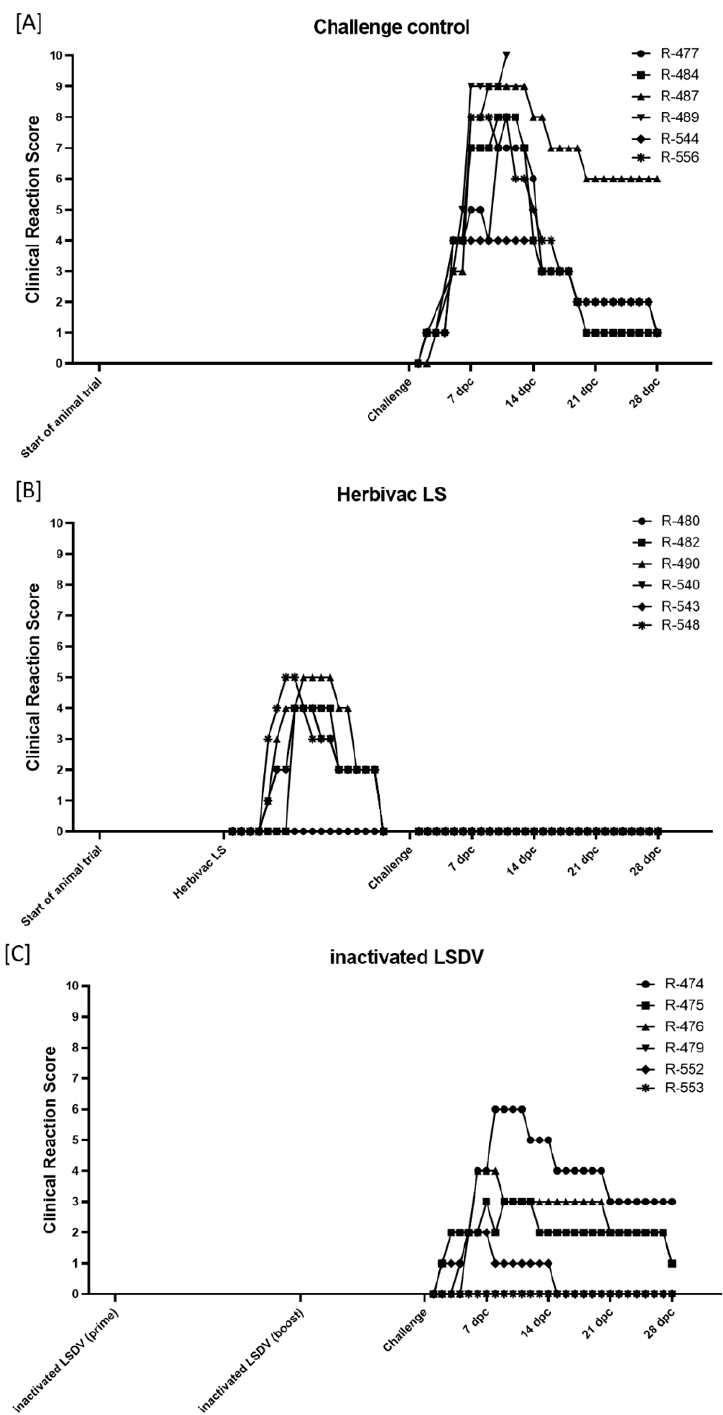
Figure 3. Clinical reaction score of the cattle during the proof-of-concept animal trial. Clinical reaction score was measured daily starting a few days before first vaccination with inactivated LSDV until 28 dpc. ( A ) Cattle of Group 1A were left unvaccinated and served as challenge control group. ( B ) Cattle of Group 1B received the commercially available life-attenuated vaccine “Herbivac LS”, and ( C ) cattle of Group 1C were vaccinated with an inactivated vaccine prototype on basis of LSDV-“Neethling vaccine” strain.